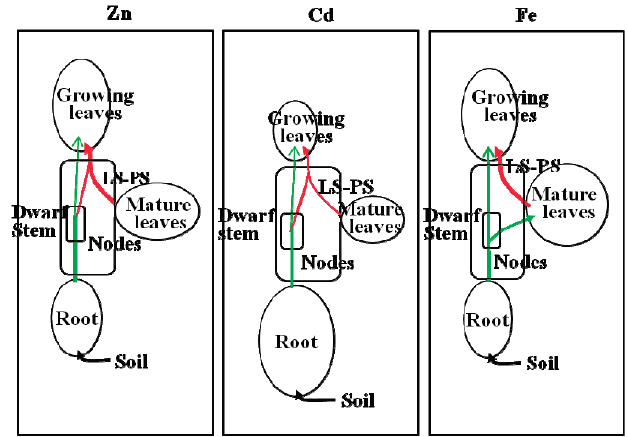
Figure 4. Models of the transport of Zn, Cd, and Fe via xylem and phloem in rice plants at the vegetative stage. “Leaves” are leaf blades. “Stem” includes the dwarf culm and leaf sheaths. The green line shows xylem transport. The red line shows phloem transport. Phloem sap was collected from the leaf sheaths (LS-PS). Information is from Yoneyama et al. [55]. Important note: At the vegetative nodes of the dwarf stem, Zn and Cd ascending xylem (green line) are transferred to the phloem (red line) via the xylem-to-phloem transfer system at the nodes, while Fe in the xylem (in the form of Fe–citrate) does not pass through this system.